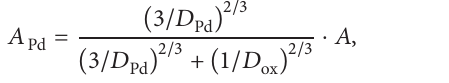
do not fabricate simultaneously with Pd MSM diodes.